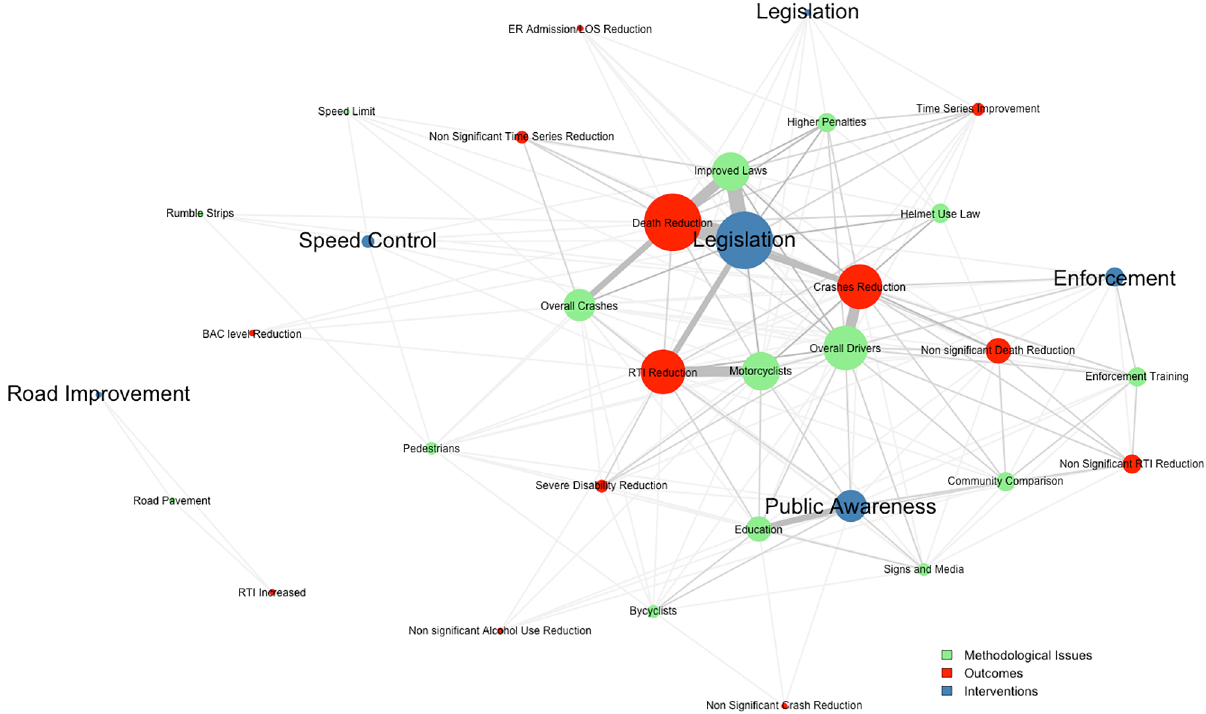
Fig 3. Synthesis of Road Traffic Interventions and